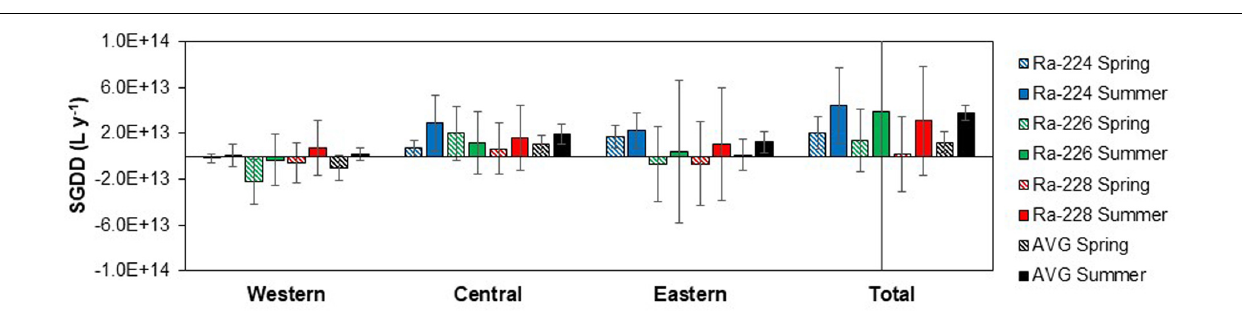
FIGURE 5 | Summary of Ra-derived SGD estimates to Long Island Sound, arranged by basin and season. The average spring and summer values (black) represent an average ( ± standard deviation) of all three Ra isotopes. A negative SGD flux implies either that Ra sources approximately balance Ra sinks (within the propagated uncertainties), or that one (or more) known Ra flux is improperly